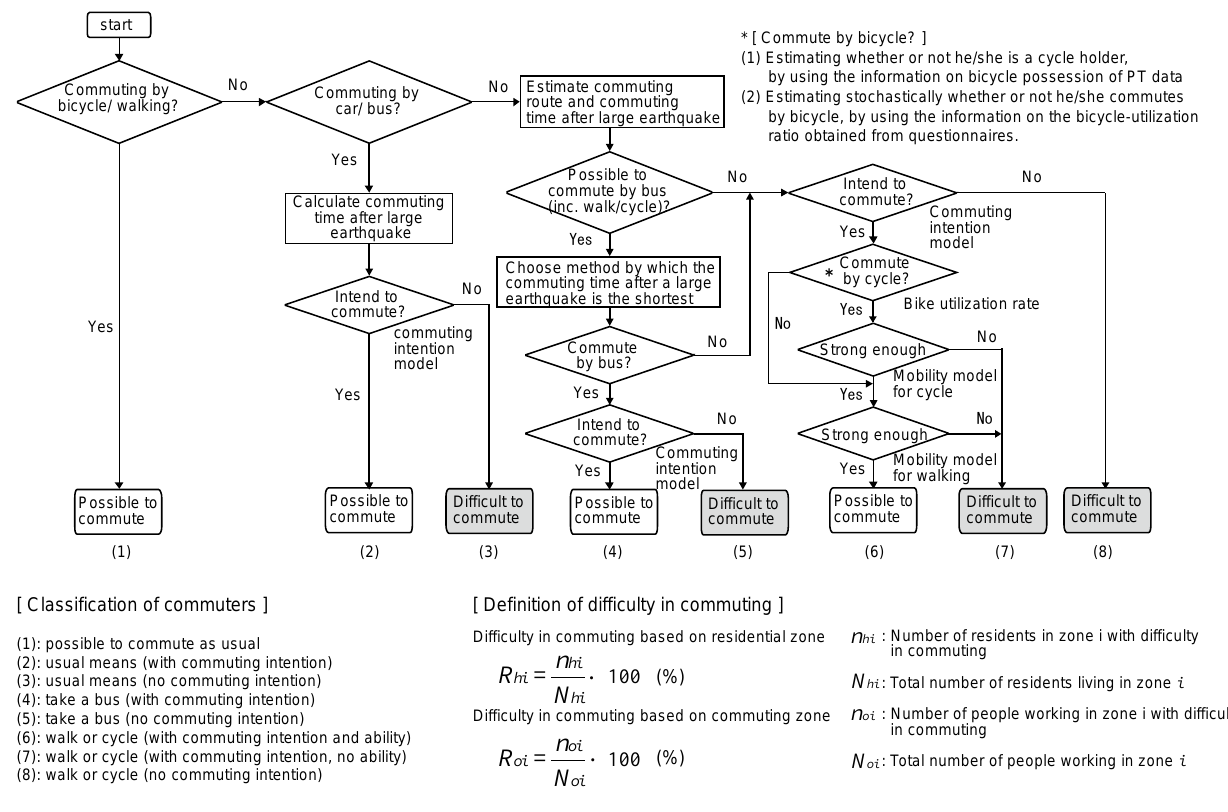
Figure 7. Flowchart assessing overall ability of workers to commute from home to workplace after a severe earthquake as determined in this